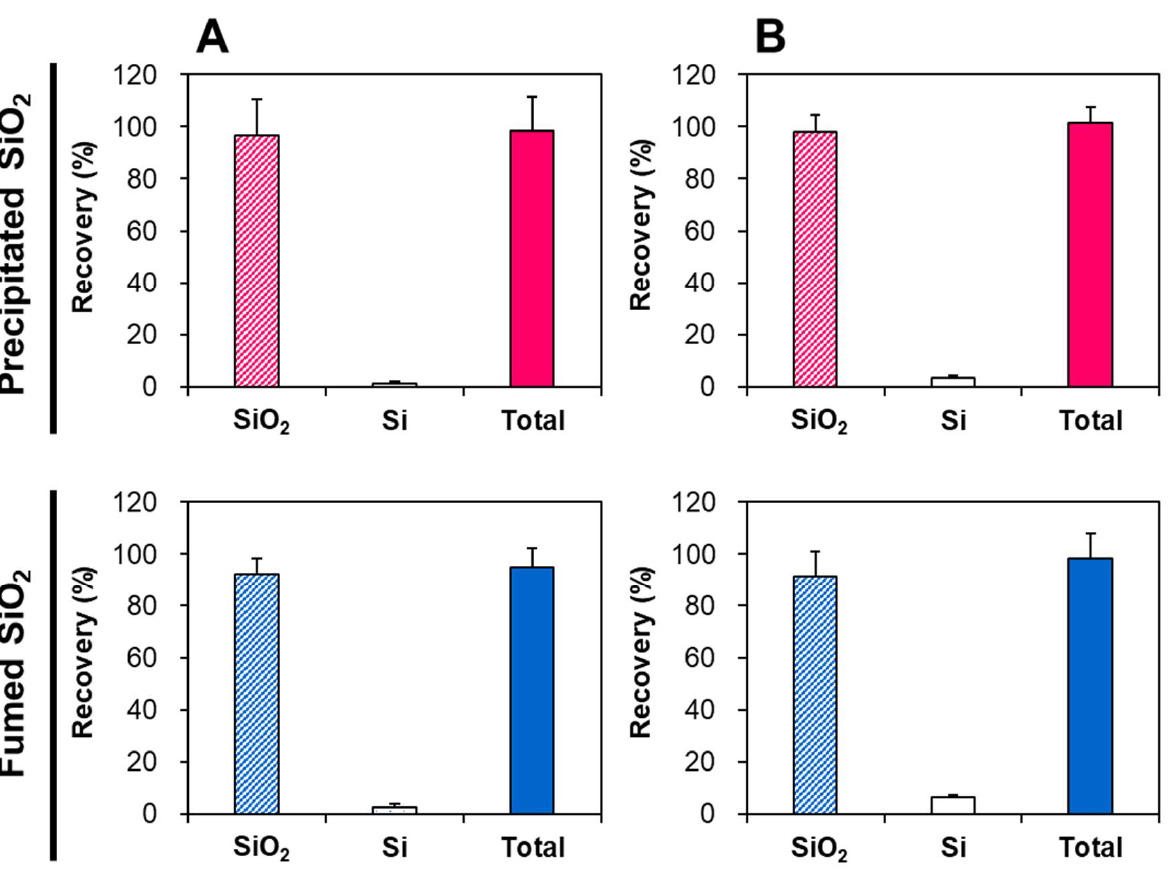
Figure 4. Recoveries (%) of SiO 2 particles, Si ions, and total Si levels in ( A ) SiO 2 -spiked Caco-2 cells and ( B ) SiO 2 -spiked liver, obtained via cloud point extraction (CPE).